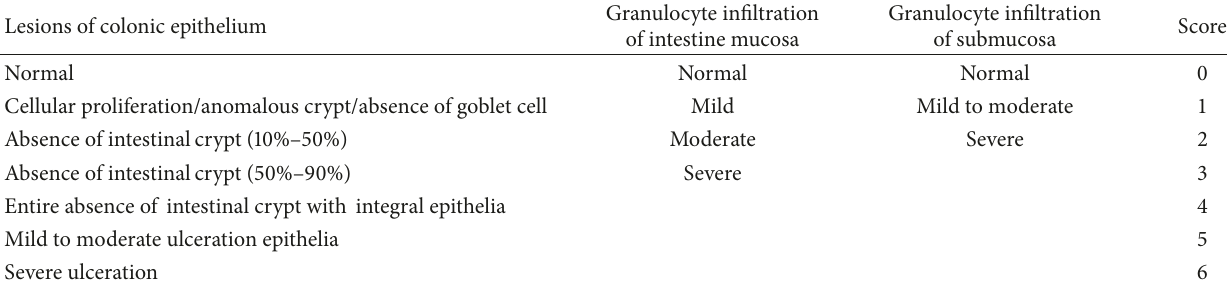
Table 3: Histology